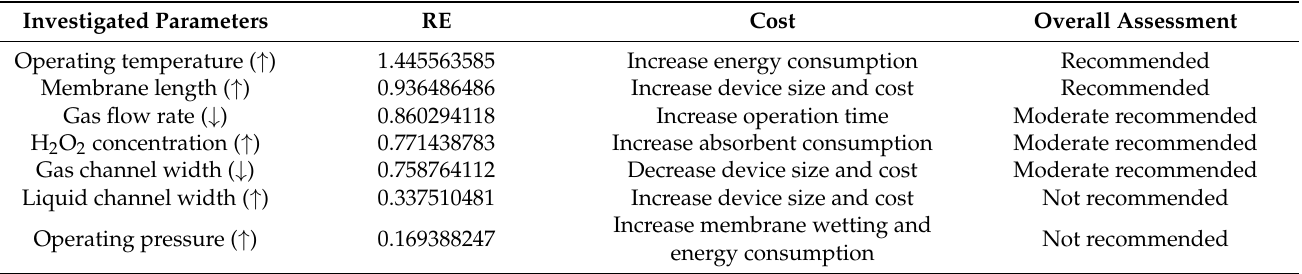
Table 1. Relative enhancement and assessment of investigated parameters on NO reduction efficiency (listed in descend- ing